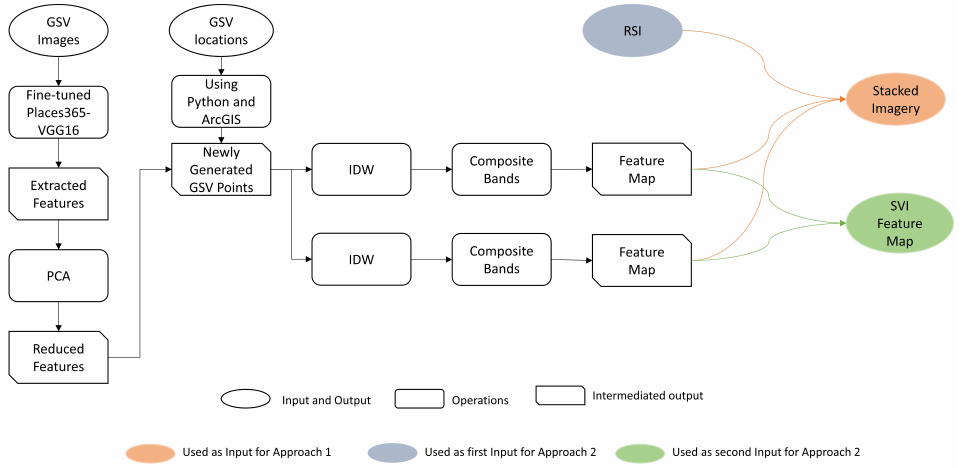
Figure 8. Preparing feature maps and the input data for Approaches 1 and 2 (this figure only demon- strates the procedure for creating two feature maps; likewise, 32 feature maps can be